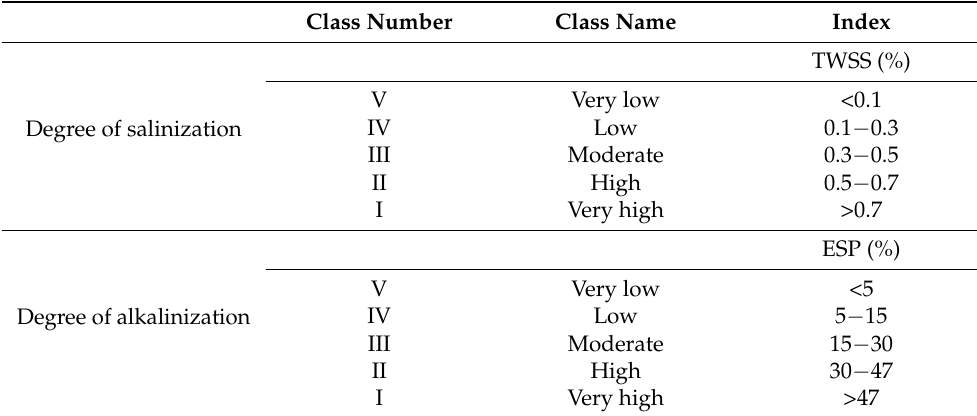
Table 2. Quantitative standard saline soil classification.